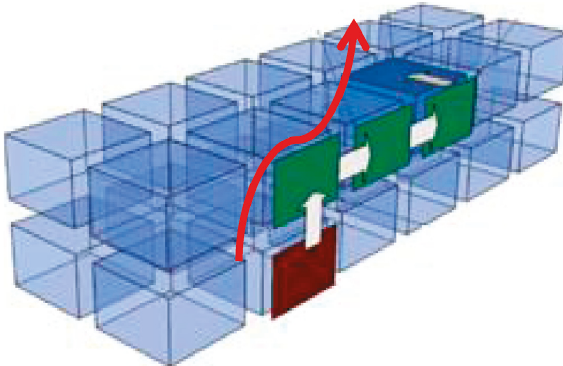
Figure 5: Primary energy transfer path between subsystems.